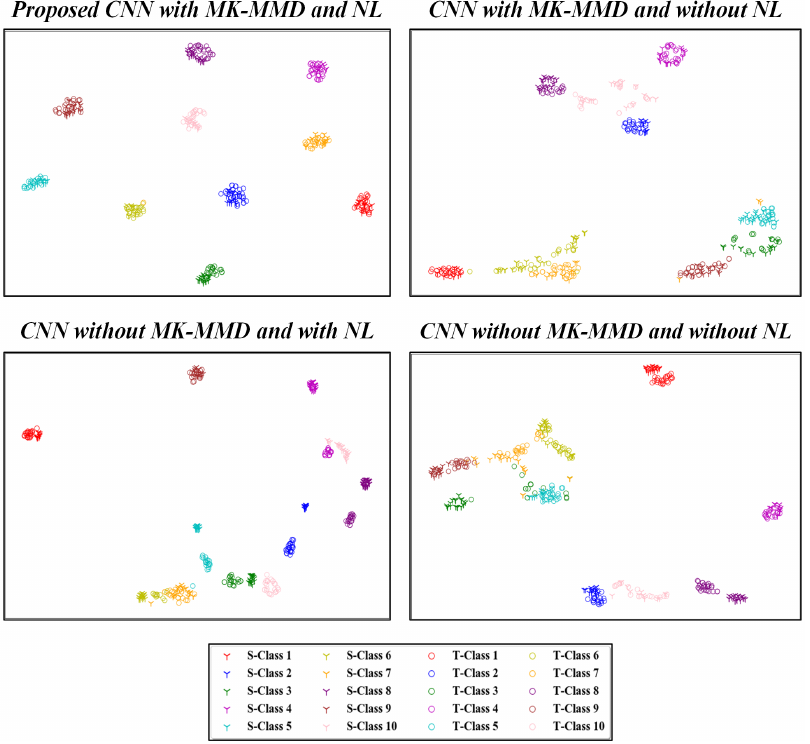
Figure 11. Visualization results of high-level features in the fully connected layer by different methods. S - and T -denotes source and target domains, respectively. Task T 1 of the CWRU dataset is focused